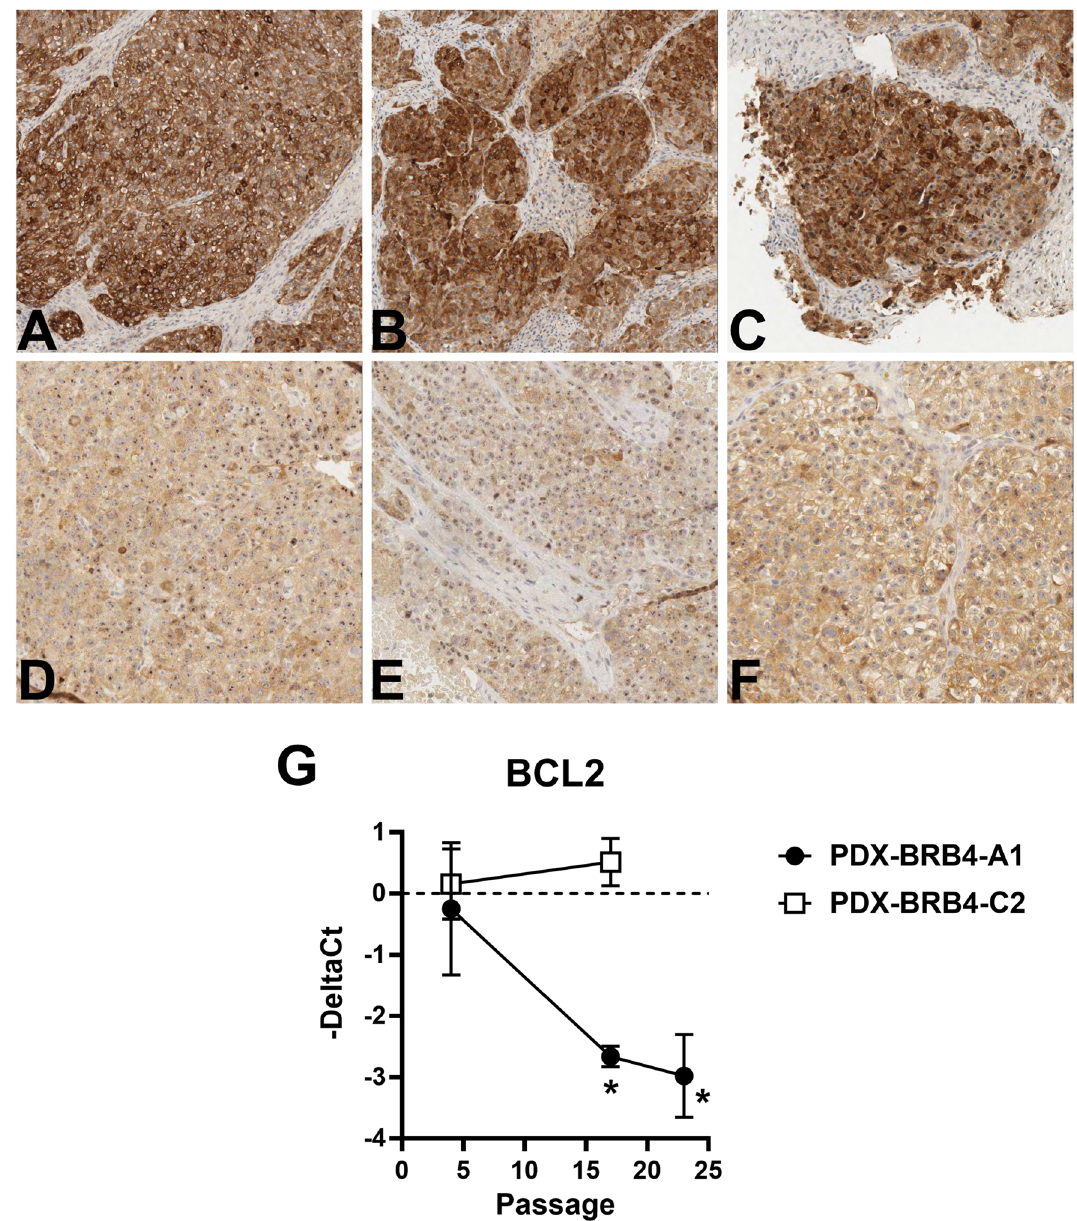
Figure 4. Decrease of BCL2 expression during tumor progression. ( A – F ) Immuno-histochemical expression of BCL2 in PDX-BRB4-A1 at low-passage (5–7 passages, panels A – C ) and in its progressed high-passage subline (23–26 passages, panels D – F ). Sections were immunostained with antibodies against BCL2 biomarker. ( G ) RT-PCR expression level of BCL2α in PDX-BRB4 sublines at different in vivo passages. Mean and SEM from three independent replicates is shown. Significance: linear regression of BCL2 in PDX-BRB4-A1 subline, p < 0.01; *p < 0.05 high-passage A1 versus low-passage A1 and versus C2.